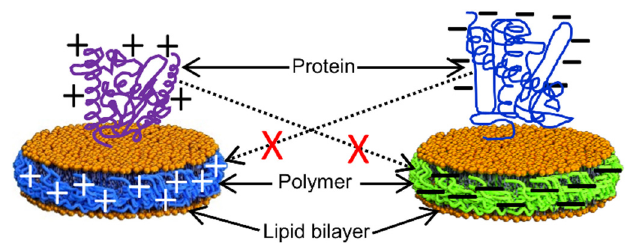
Figure 10. Schematic showing the lipid-nanodiscs containing positively-charged polymers and a positively-charged protein ( left ), negatively-charged polymers, and a negatively-charged protein ( right ). Due to opposite charges, non-specific interactions occur between the belt-forming polymers and the reconstituted protein at a given pH which would reduce the stability of nanodiscs and also lead to structural changes and aggregation. Hence, the synthetic polymer used and the membrane protein to be reconstituted/studied should possess the same net charge.